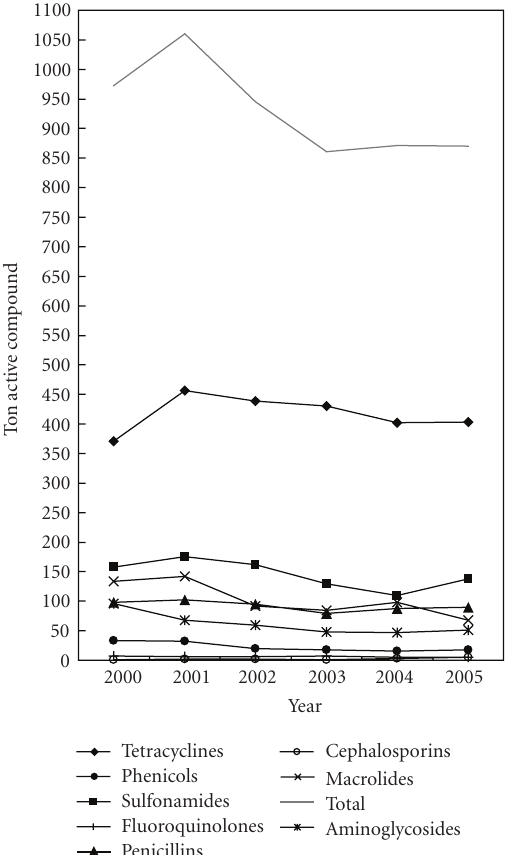
Figure 1: Trends in veterinary antimicrobials sold from pharmacies in